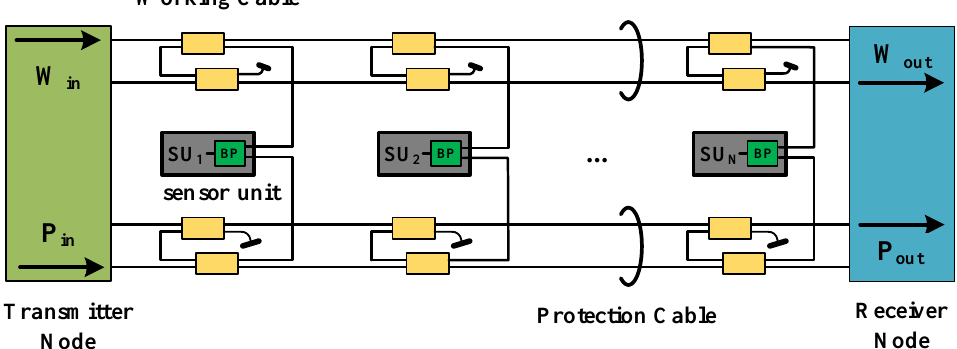
Figure 1. The fiber bus protection scheme [40]; BP: branching point, SU: sensor units, W in : working cable input, W out : working cable output, P in : protection cable input, and P out protection cable output.